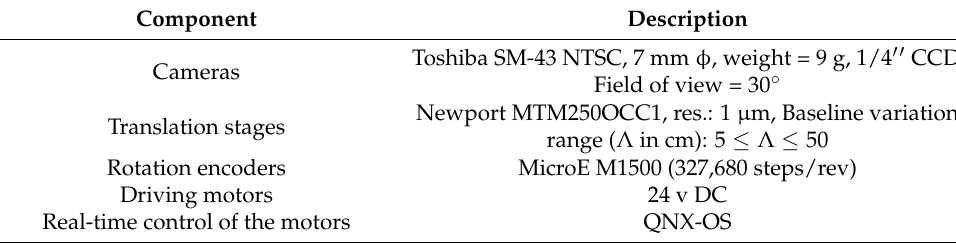
Table 1. Details on the components of the